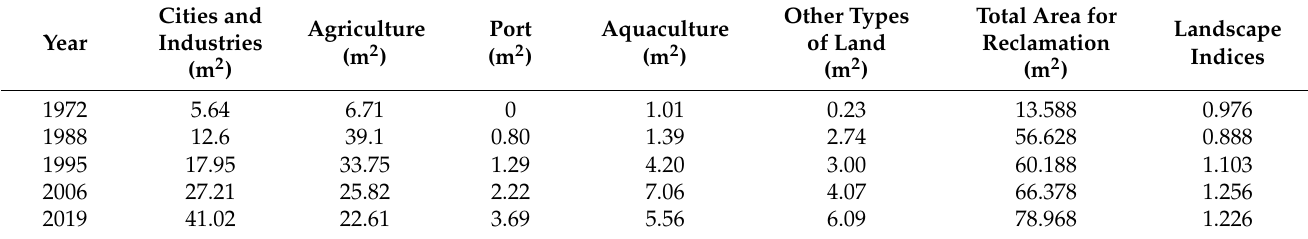
Table 4. Reclamation area and landscape indices of Quanzhou Bay at different